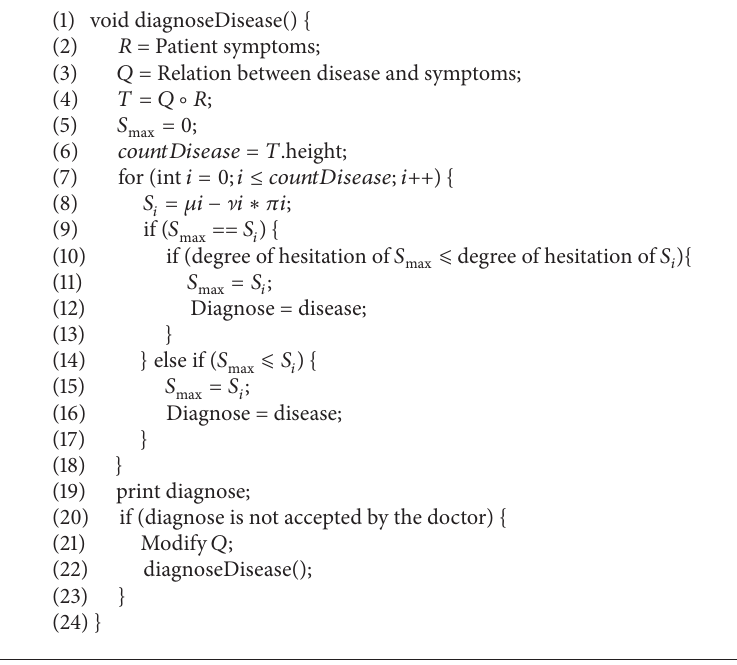
Algorithm 1: IF neurons in medical diagnosis.